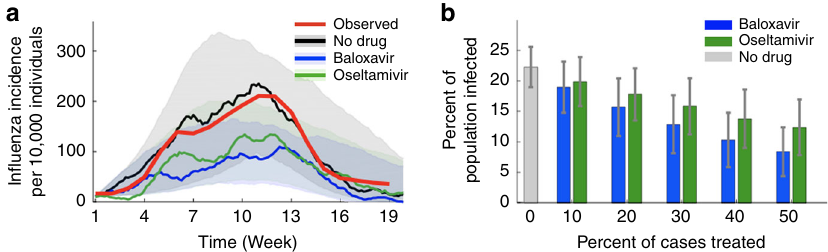
Fig. 3 Mitigation of seasonal in fl uenza with mass antiviral treatment. a Observed incidence of in fl uenza virus (red) based on US surveillance data from the 2017 – 2018 in fl uenza season compared with typical model simulations without any antiviral treatment (black) or with 30% of cases receiving baloxavir (blue) or oseltamivir (green) treatment. Lines indicate a moving 10-day average of incidence; shading corresponds to the 80% prediction interval across 1000 stochastic simulations. b Estimated total attack rates in simulated intervention scenarios ranging from no cases receiving antiviral treatment to 50% of cases treated. The heights of the columns and error bars show the median values and interquartile range, respectively, across n = 1000 independent stochastic simulations for each scenario. Each stochastic simulation assumes a population of 10,000 individuals, with within-host viral replication and between-host transmission parameters given in Table